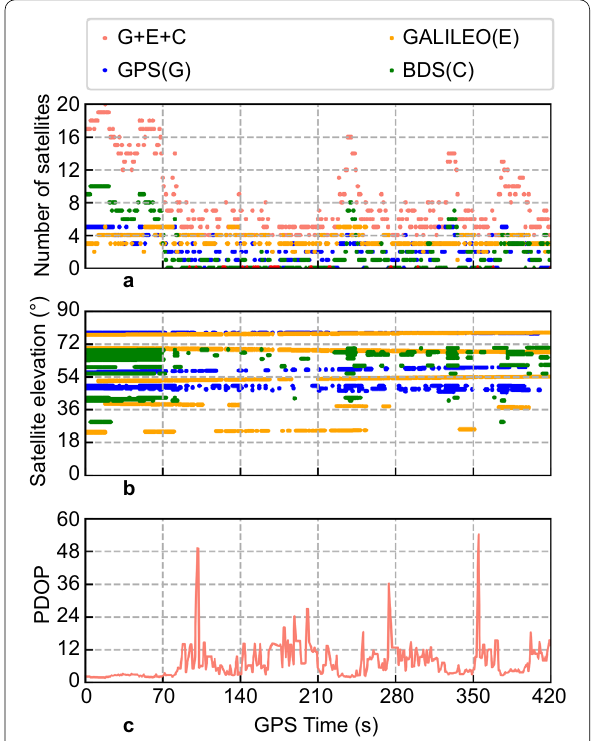
Fig. 12 Number of available GNSS satellites ( a ), continuity and elevation of satellites ( b ), PDOP of multi-GNSS PPP ( c ) in GNSS difficult experiment Fig. 13 Position offsets of multi-GNSS PPP/INS and GIL methods in